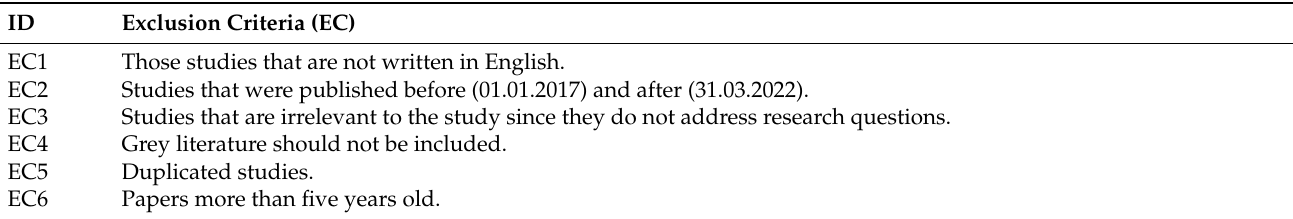
Table 5. Exclusion criteria for systematic literature